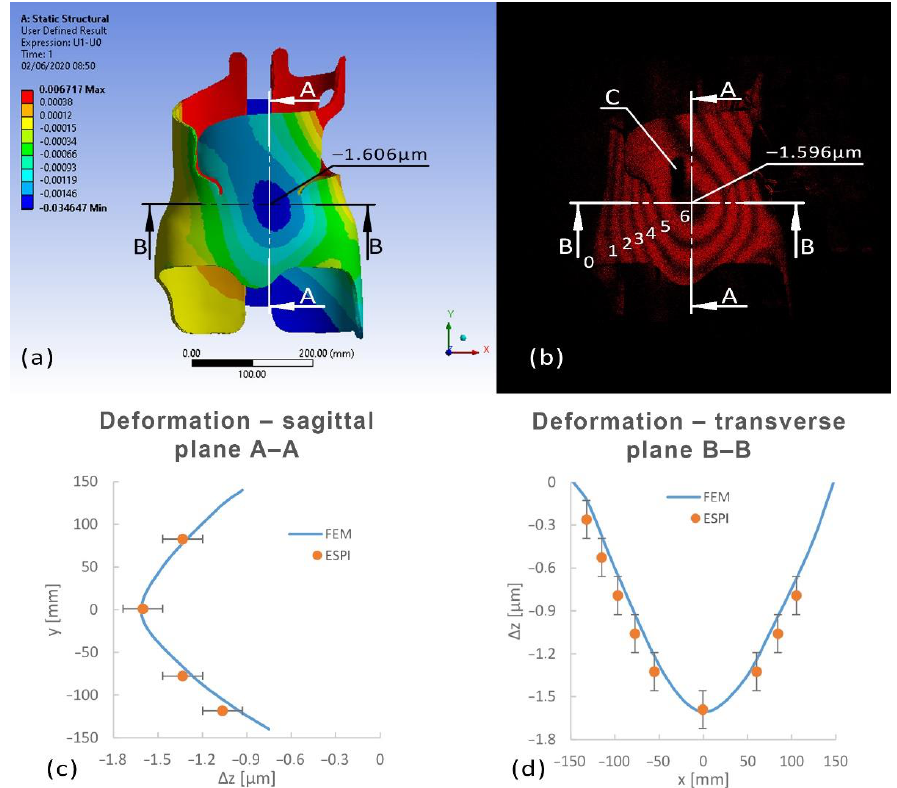
Figure 6. Comparison of displacement distribution results in the Z direction: ( a ) displacement distribution obtained from FEM numerical analysis, ( b ) displacement distribution obtained from ESPI measurements: numbers n = 0, 1, ..., 6, associated with the value of displacement according to Equation (1), indicate correlation fringes of successive orders of interference (C—artifact resulting from excessively intensive laser beam reflex), ( c ) deformation graph in the sagittal plane A–A, and ( d ) deformation graph in the transverse plane B–B.